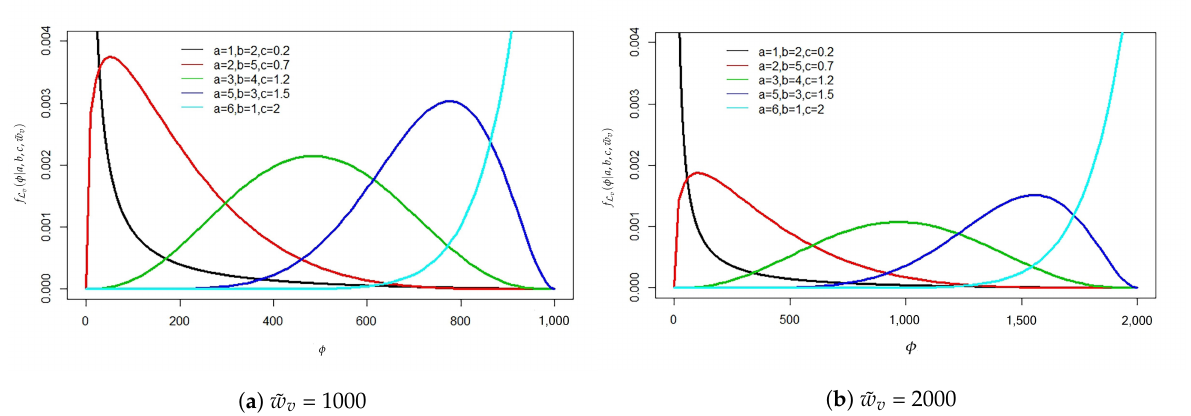
Figure 6. Profile of losses caused by infection following a generalized beta distribution for the given